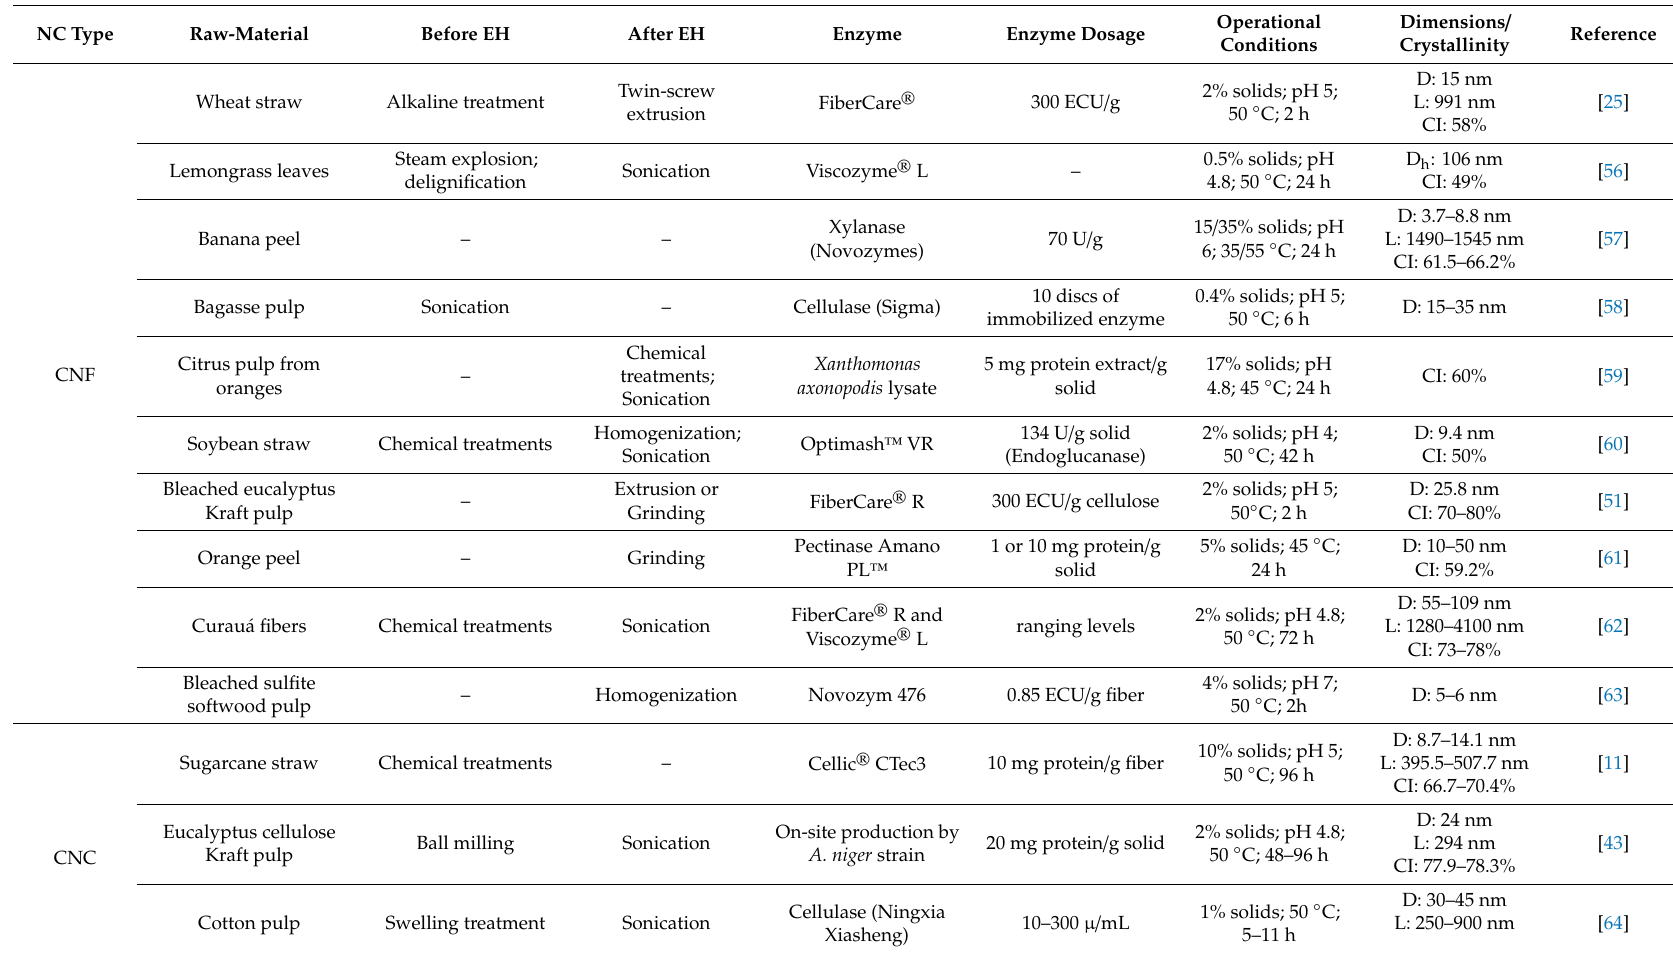
Table 2. General description of previous studies reporting the production of CNFs and CNCs by enzymatic